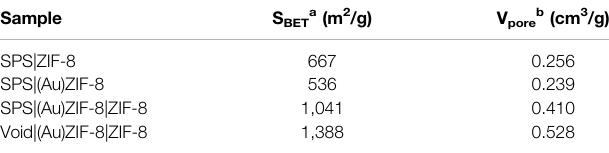
TABLE 1 | The summary of surface area and pore volume for each step